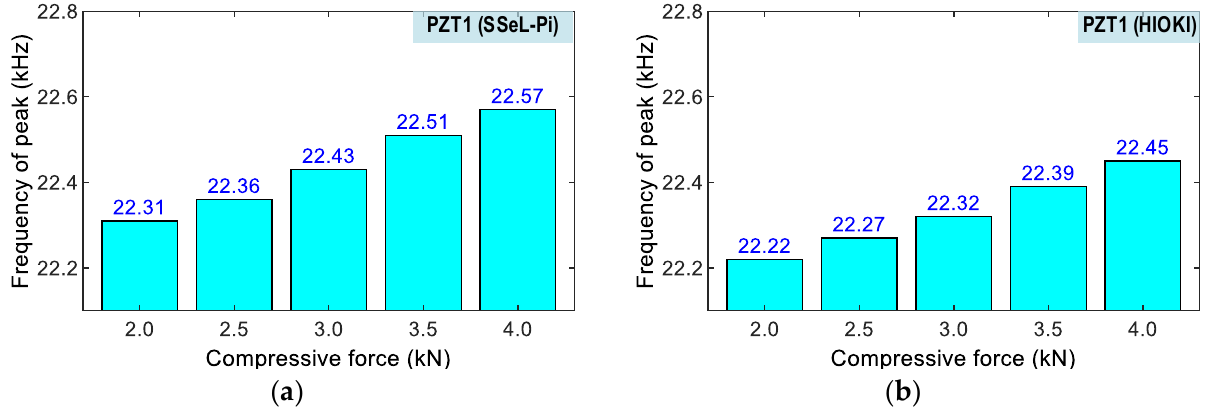
Figure 21. Frequency shifts of PZT 1 corresponding to compressive loadings P1 – P5. ( a ) SSeL-Pi, ( b ) HIOKI-3532.